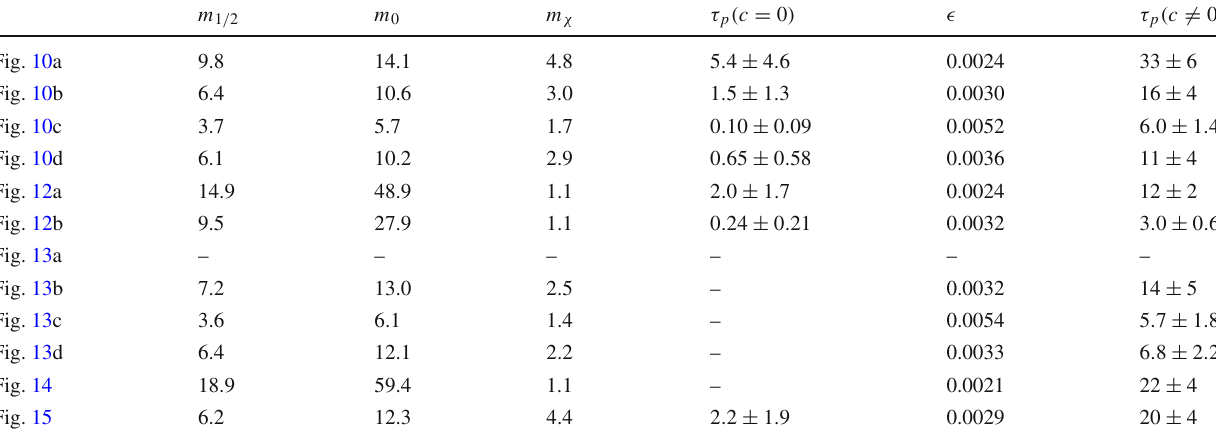
Table 6 Lifetimes at points with (cid:23) χ h 2 ≈ 0 . 12, and m h ≈ 125 GeV. Masses are in TeV and lifetimes in units of 10 33 years